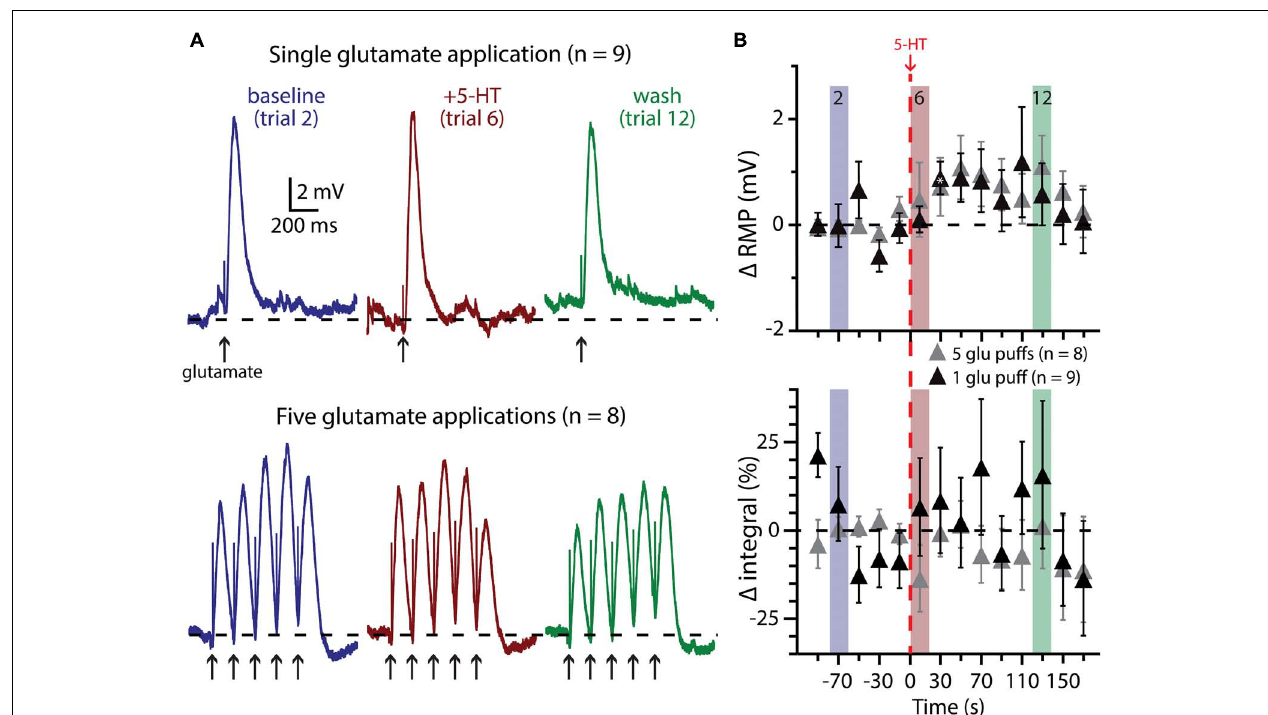
FIGURE 7 | Subthreshold glutamatergic drive fails to enhance serotonergic excitation of COM-excited L5PNs. (A) Responses of COM-excited L5PNs to single glutamate applications (top traces; n = 9) or to bursts of five glutamate applications (bottom traces; n = 8) in baseline conditions (blue), after 5-HT application (red), and approximately two minutes